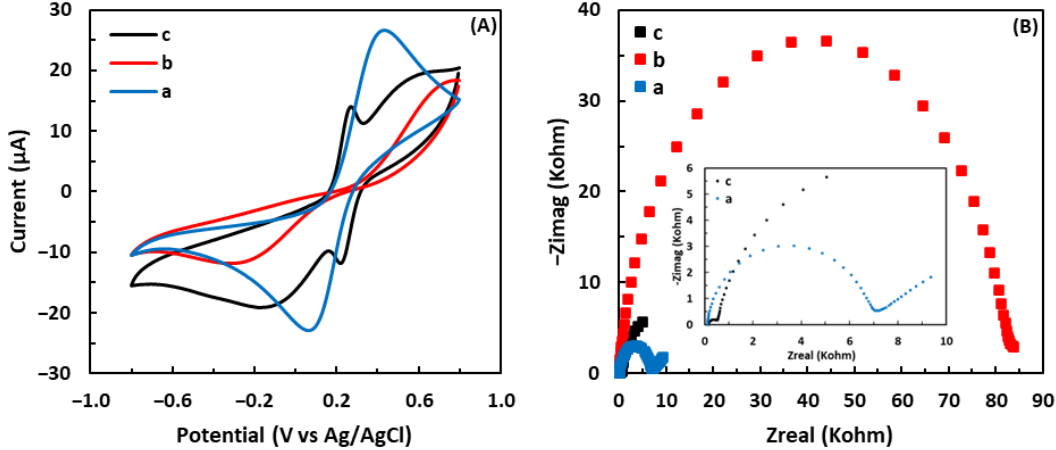
Figure 2. ( A ) Cyclic voltammograms and ( B ) Nyquist plots for (a) the bare electrode, (b) the aryl diazonium-modified electrode, and (c) the GSH-modified electrode, in 5 mM solution of [Fe(CN) 6 ] 3−/4− containing 0.1 M KCl.